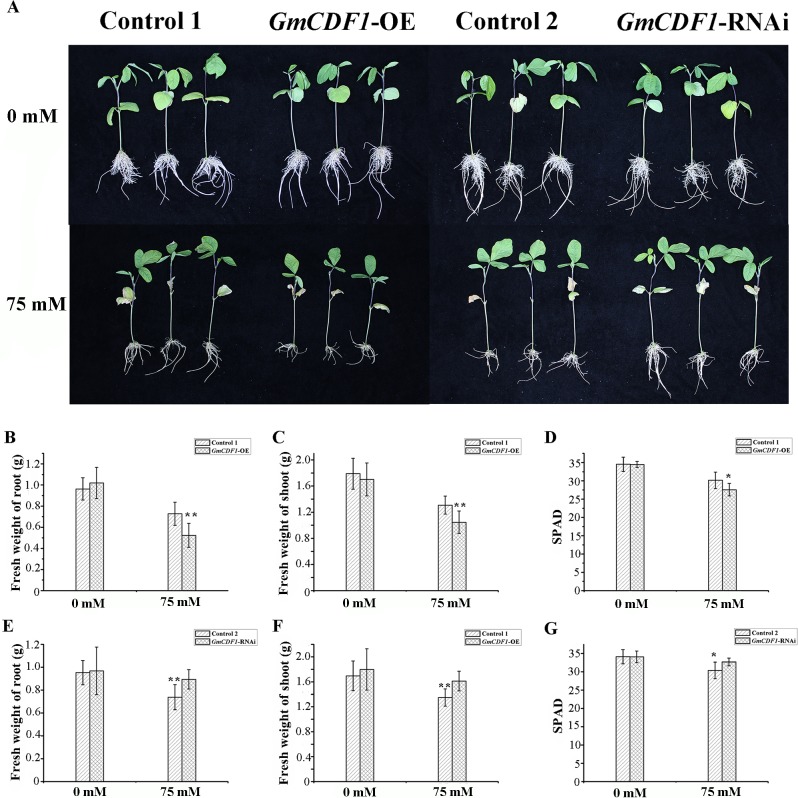
Performance of GmCDF1 transgenic hairy roots under salt stress.(A) Growth of transgenic hairy roots and non-transgenic shoots treated with 0 mM or 75 mM NaCl for four days. More than 60 samples were analyzed, and three typical lines were selected. GmCDF1-OE: soybean hairy roots overexpressing GmCDF1 Control 1: soybean hairy roots with the empty vector pMDC83; GmCDF1-RNAi: soybean hairy roots in which GmCDF1 is silenced; Control 2: soybean hairy roots with the empty vector pB7GWIWG2(II). (B) Fresh weight of GmCDF1-OE and Control 1 hairy roots, (C) fresh weight of GmCDF1-OE and Control 1 shoots, and (D) SPAD values of their non-transgenic leaves treatment with 0 mM or 75 mM NaCl for four days. The data are presented as the means±SEs (n≥5). (E) Fresh weight of GmCDF1-RNAi and Control 2 hairy roots, (F) fresh weight of GmCDF1-RNAi and Control 2 shoots and (G) SPAD values of their non-transgenic leaves treatedwith 0 mM or 75 mM NaCl for four days. The data are presented as the means±SEs (n≥5). Statistical significance was detected by a two-tailed t-test. (**P<0.01, ***P<0.001).